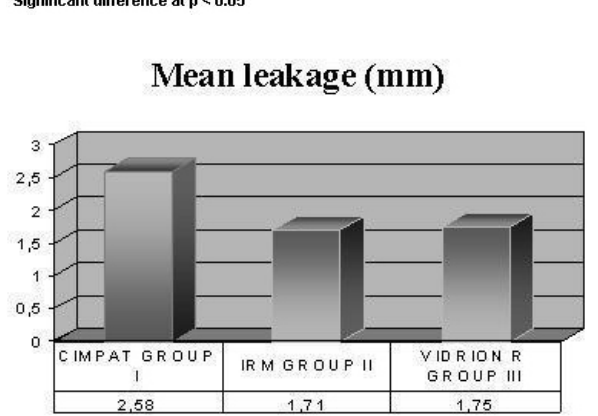
FIGURE 1- Grafic representation of mean